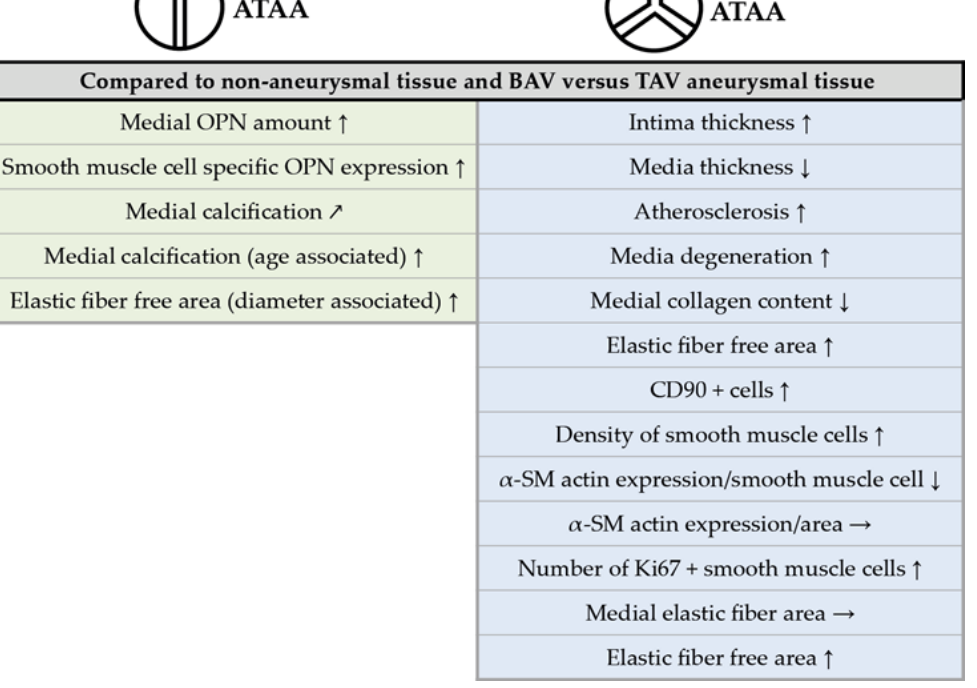
Figure 7. Summary of observed changes in the aortic wall of BAV- and TAV-associated aneurysm patients. Figure 7 gives an overview on classical changes in the aneurysmal aortic wall and provides new information on BAV- and TAV-ATAA phenotypes. The summary of the results indicates a massive difference between BAV- and TAV-ATAA tissues, arguing for different pathological processes to occur in the two patient groups. The TAV is characterized by massive structural changes that are likely to weaken the aortic wall; atherosclerosis as a risk factor for TAV-associated ATAA formation may be re-considered. Pathological changes in BAV-ATAA tissue, that were observed, are limited to age-associated increased calcification and increased expression of OPN in the media. The role of these phenotypes in BAV-ATAA formation remain unclear ( ↑ = increased; ↗ = trend to be increased; ↓ = decreased; → = unchanged).